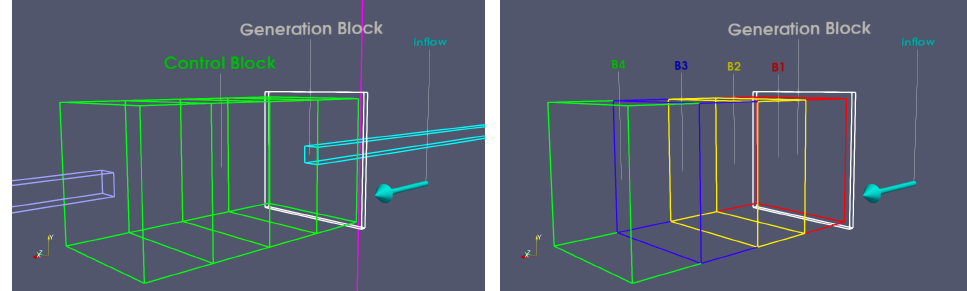
Figure 5. Layout of the computational domain grid and details of the generation and control blocks ( left ). The control block is split into four sub-blocks ( right